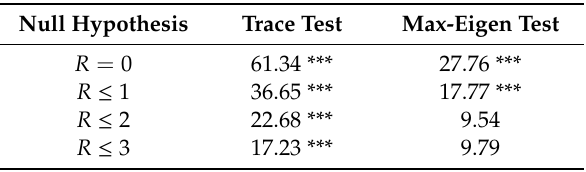
Table 4. Results of the Fisher-Johansen cointegration test.